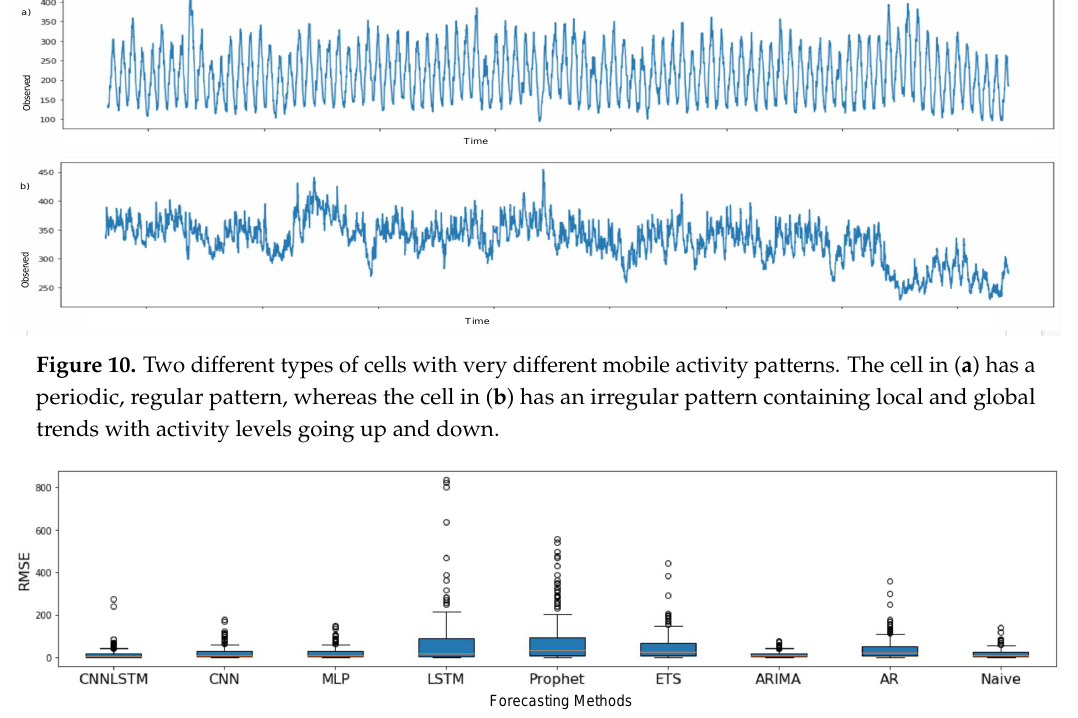
Figure 11. The distribution of RMSE across cells in a 24-h-ahead forecasting